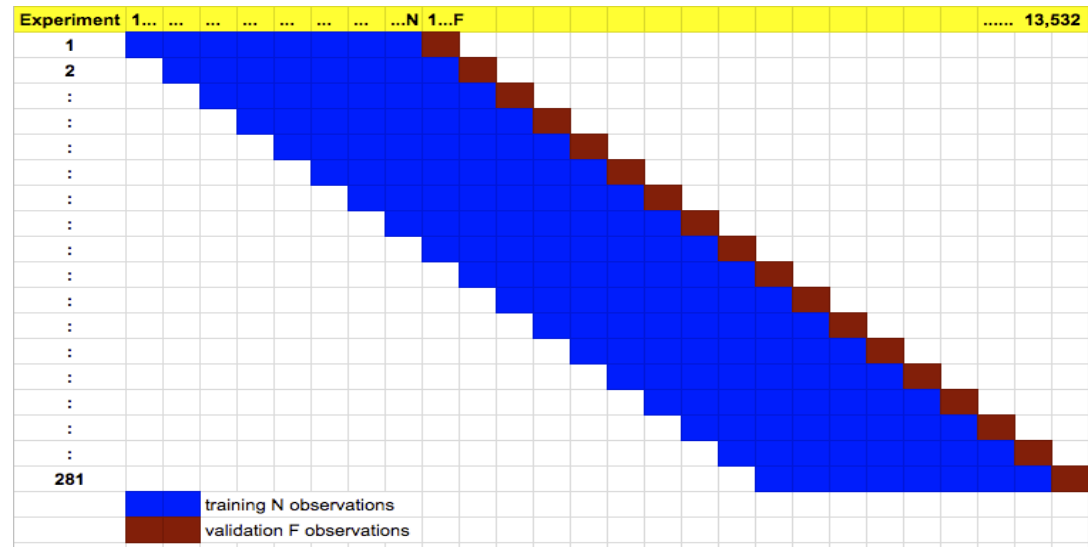
Figure 7. Sequenced training and validation